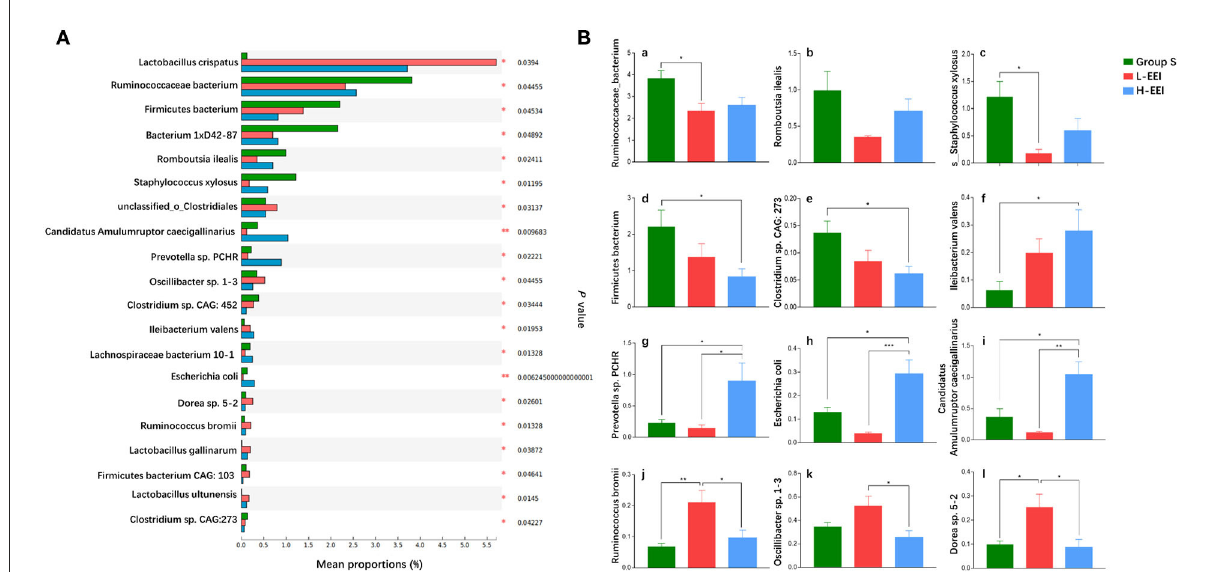
FIGURE2 Distinctive sensitivity of fecal microbiota to different concentrations of EEI. (A) The abundance of the top 20 fecal bacteria with significant differences at the species level was determined using fecal metagenomics data (Kruskal–Wallis test, P < 0.05 was considered significant). The vertical axis represents the species names, the horizontal axis represents the percentage value of a species’ abundance in the sample, and different colors represent different groups (green to group S, red to L-EEI, and blue to H-EEI). (B) Post-hoc analysis of the top 20 fecal bacteria with significant differences in (A) (Tukey–Kramer, P < 0.05 was considered significant). n = 6 in each group, * P < 0.05, ** P < 0.01, *** P < 0.001.